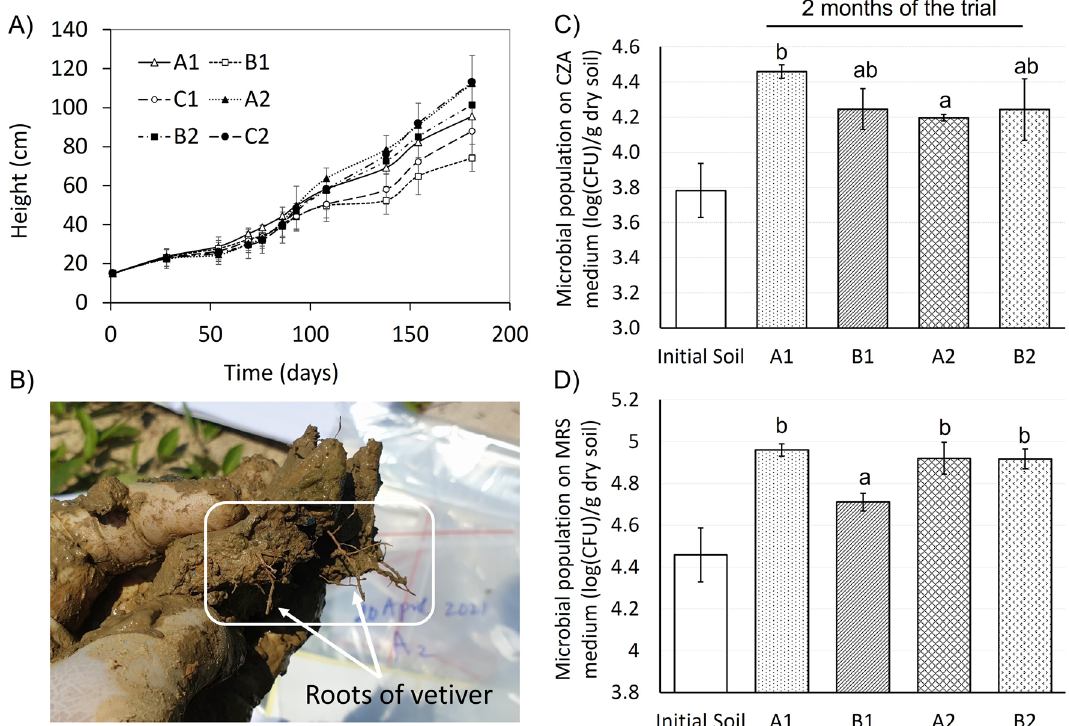
Figure 4. Vetiver growth during the court of experiment. ( A ) Vetiver growth during the course of experiment; ( B ) roots of vetiver distributed widely in the soil samples (taken on April 20, 2021), ( C , D ) microbial populations in CZA and MRS media, respectively, after 2 months of the trial. Letters a and b represent significant statistical differences (Fisher’s LSD, p <